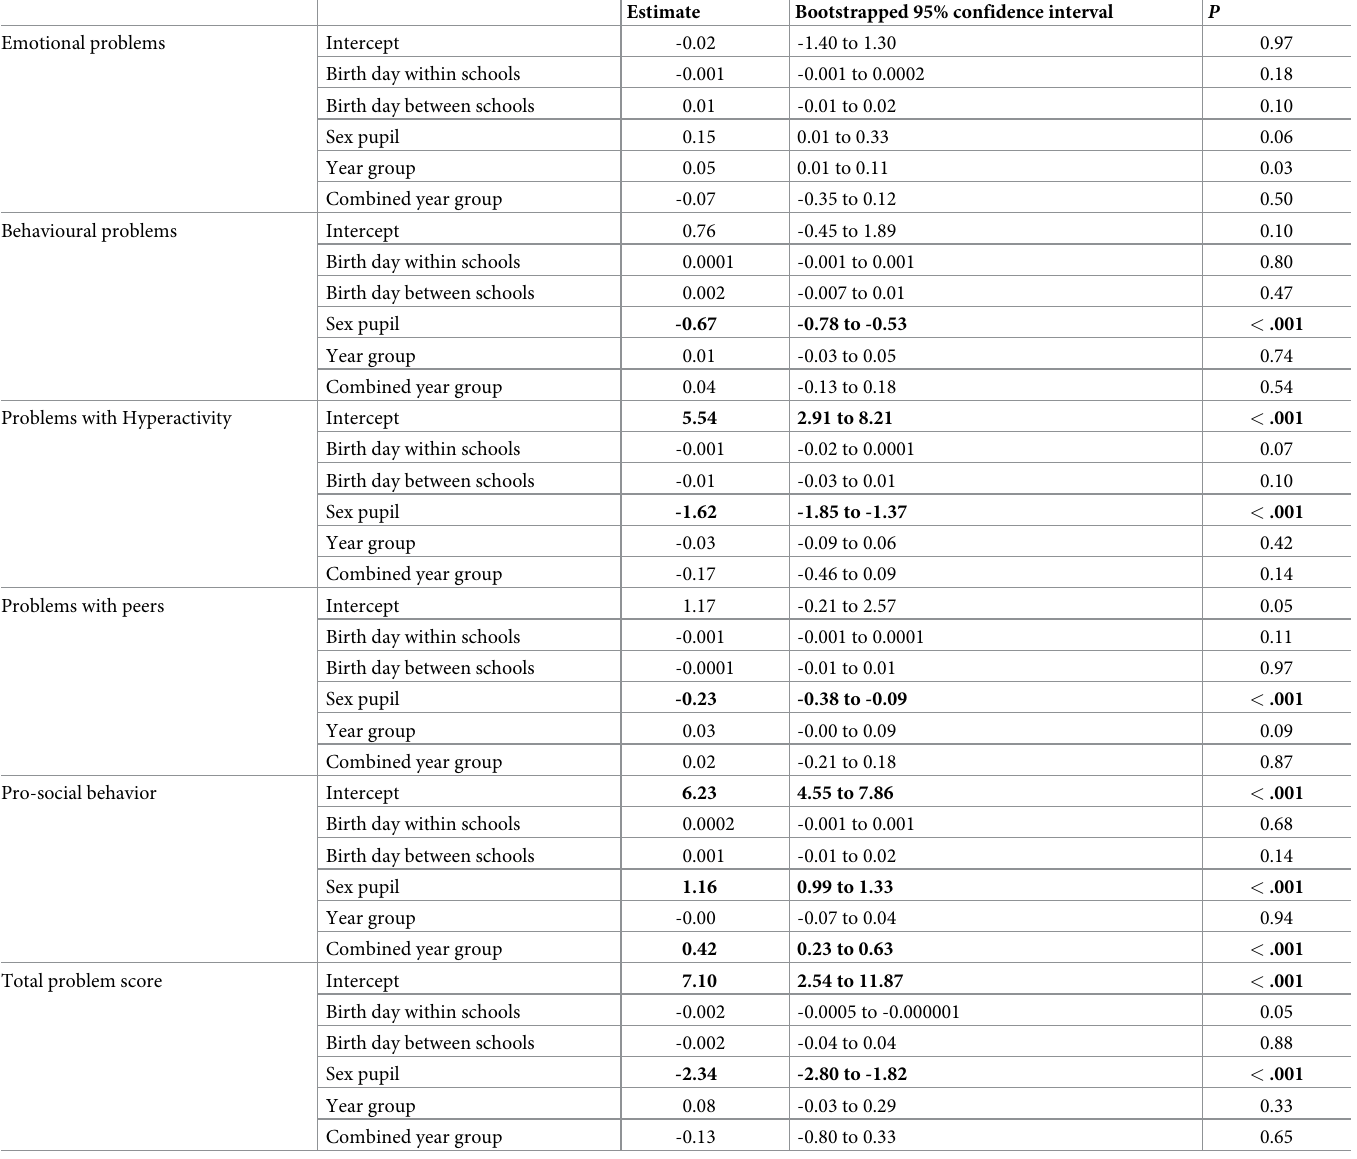
Table 3. Association between relative age and perceived problem behavior in Dutch primary